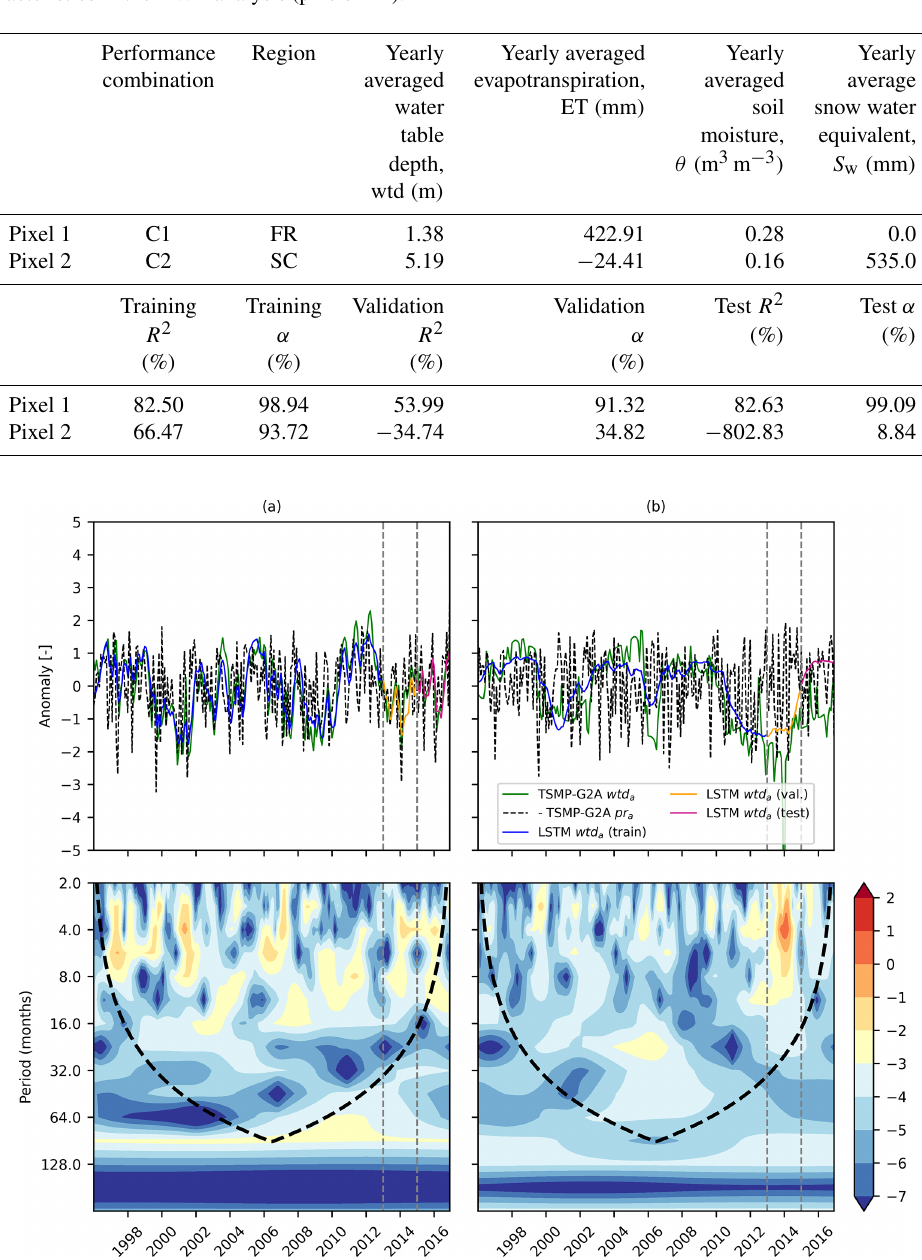
Table 5. Pixel characteristics in the XWT analysis (pixels 1–2).